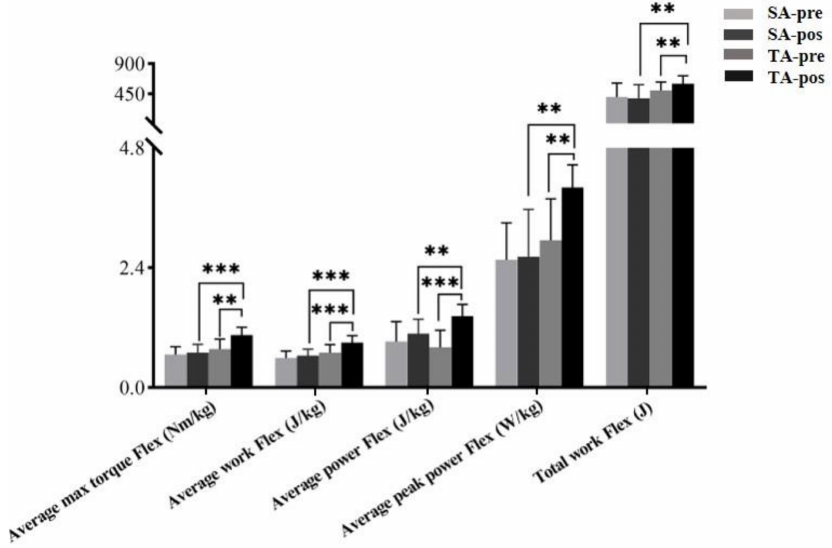
Figure 3. The simple main effects on knee flexion (Flex) before and after acupuncture for each isokinetic parameter in the SA group and TA group. True acupuncture group (TA), sham acupuncture group (SA). ** p < 0.01; *** p <